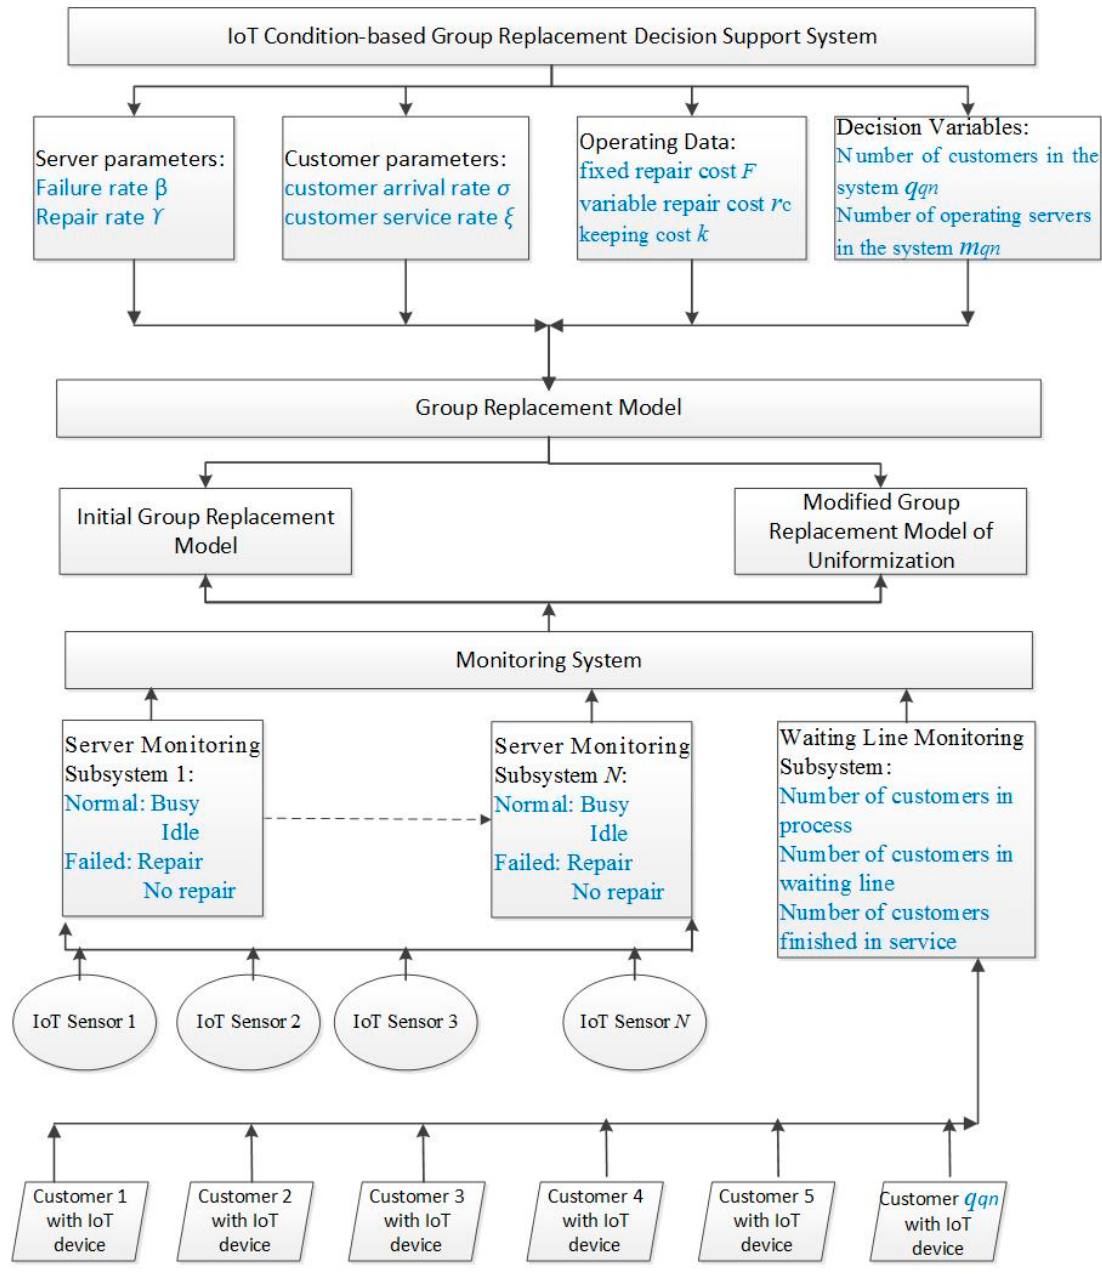
Figure 1. The structure of decision support system.